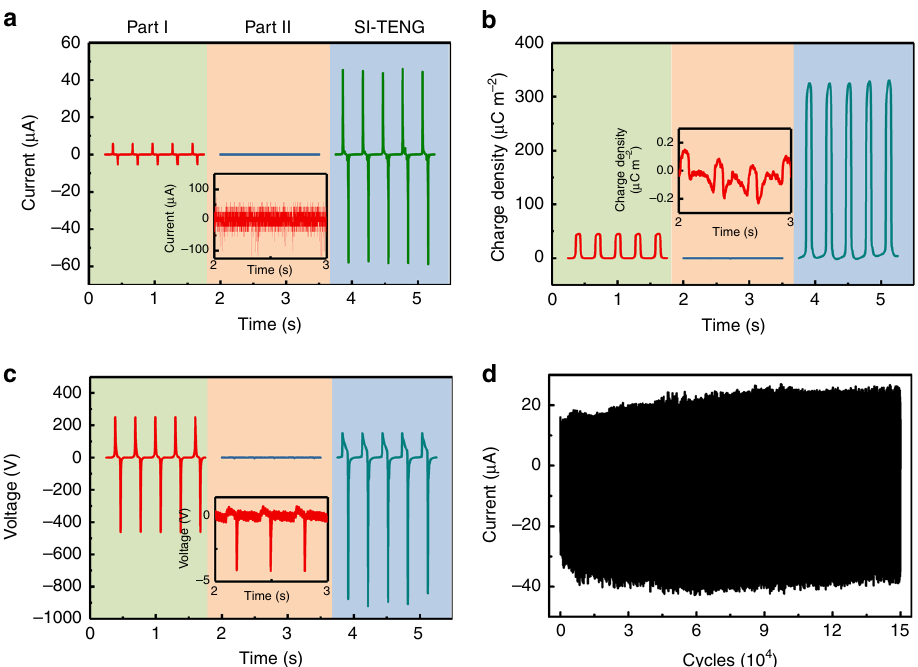
Fig. 3 Output performance of the self-improving triboelectric nanogenerator. a – c Show the output current, the transferred charge density and the output voltage, respectively, of part I (left lines), part II (middle lines), and the self-improving triboelectric nanogenerator (SI-TENG) (right lines). d Output current of the SI-TENG working continuously for 150,000 cycles at 3.33 Hz frequency